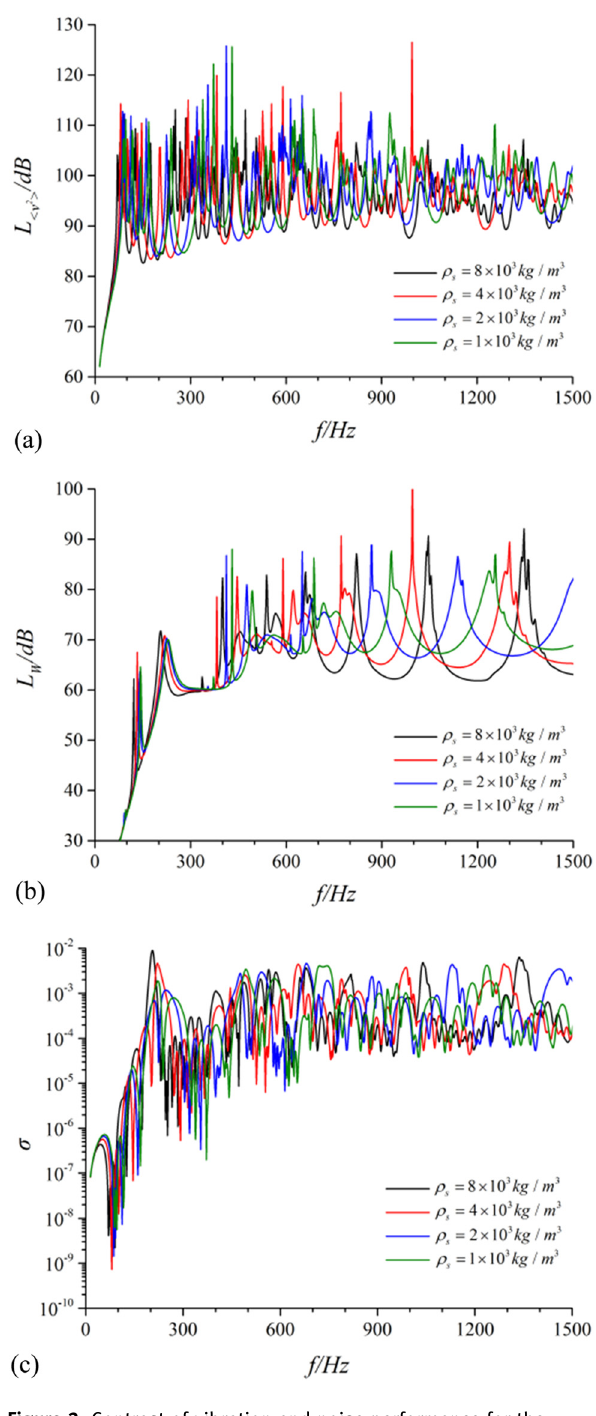
Figure 2: Contrast of vibration and noise performance for the cylindrical shell under di ff erent densities. ( a ) Radial quadratic velocity level, ( b ) sound radiation power level, and ( c ) sound radiation e ffi ciency.